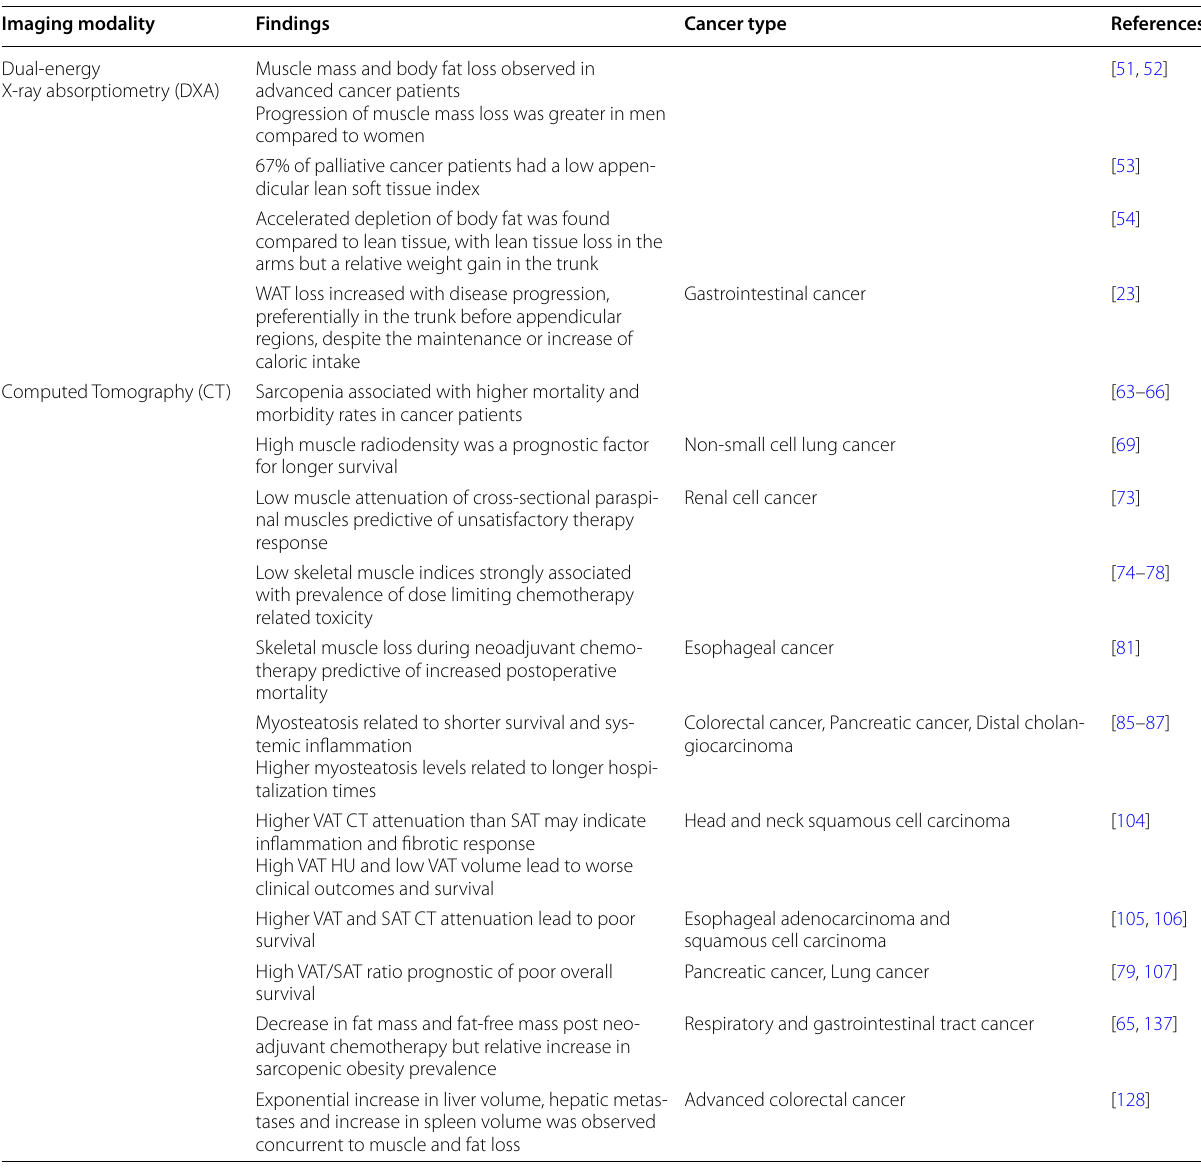
Table 1 Summary of the uses of imaging modalities in diagnosis, monitoring and prognosis and findings in cancer cachexia for different cancer